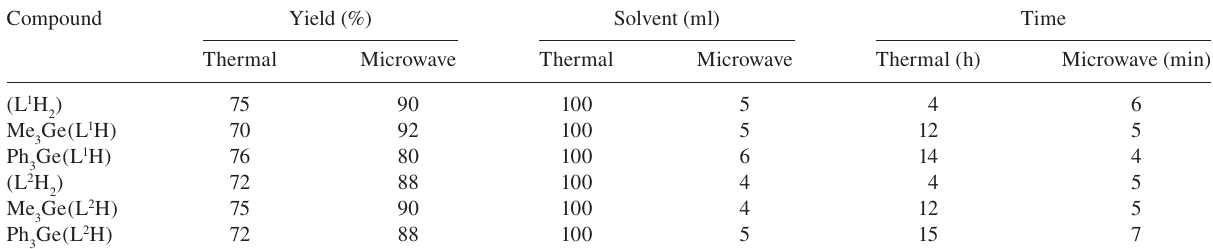
Table 7 Comparison between conventional and microwave methods of synthesis of ligands and their metal complexes.